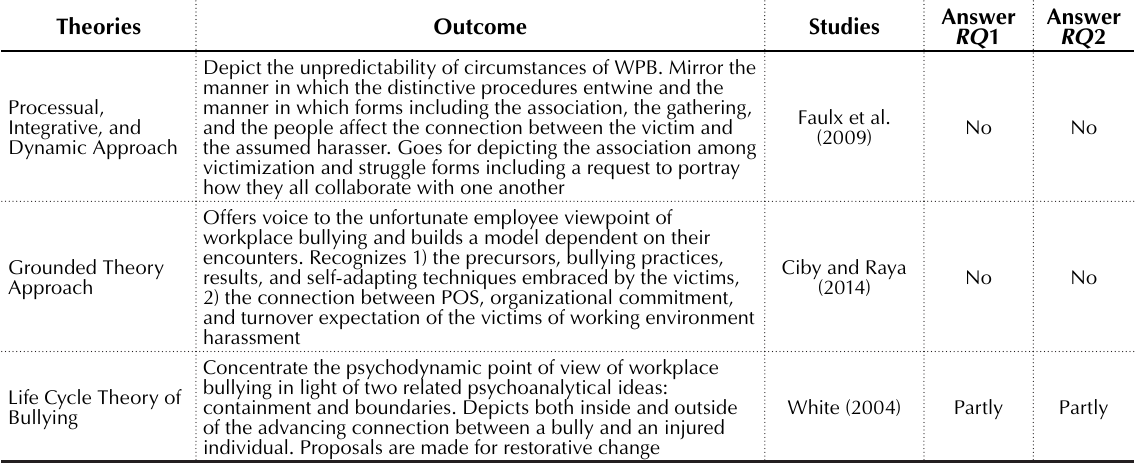
Table 3. Theories of WPB: the three Bullying Antecedent Outcome Relationship theories Theories Processual, Integrative,